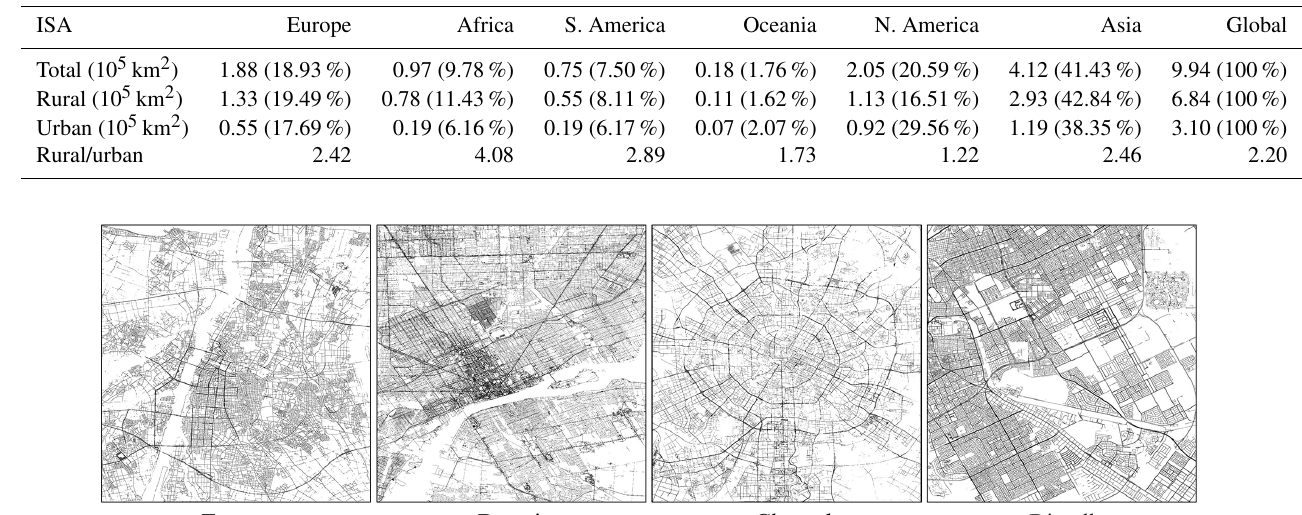
Table 6. Impervious surface area derived from GISA-10m in the six continents.